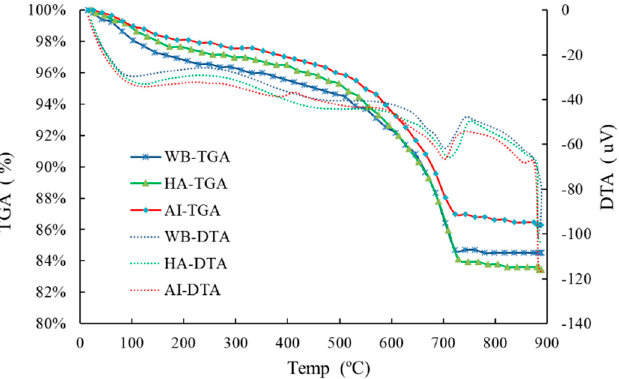
Figure 12. TG-DTA curves of the carbonation layers in different exposed environments.